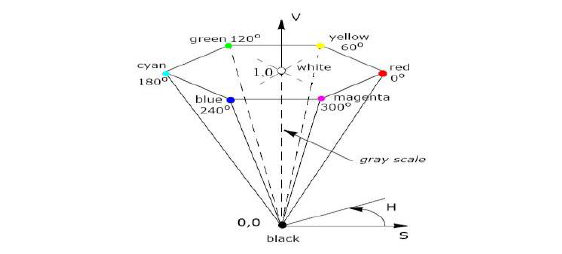
Figure 2. HSV colour